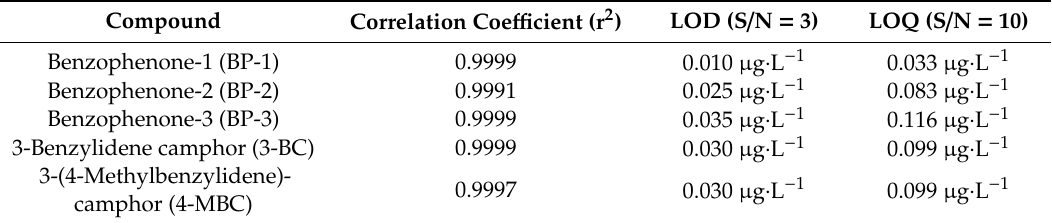
Table 2. The calibration curve parameters and detection limits of five UV